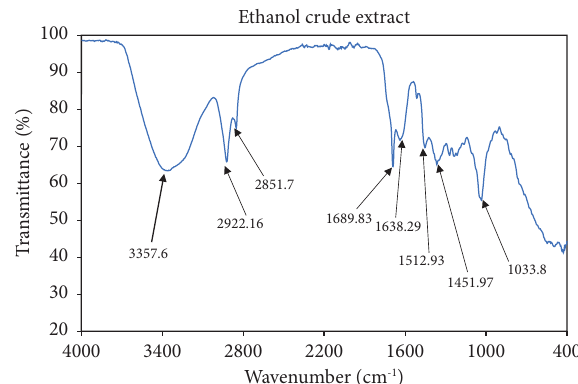
Figure 8: FTIR spectrum of ethanol crude extract of C. nioroense.